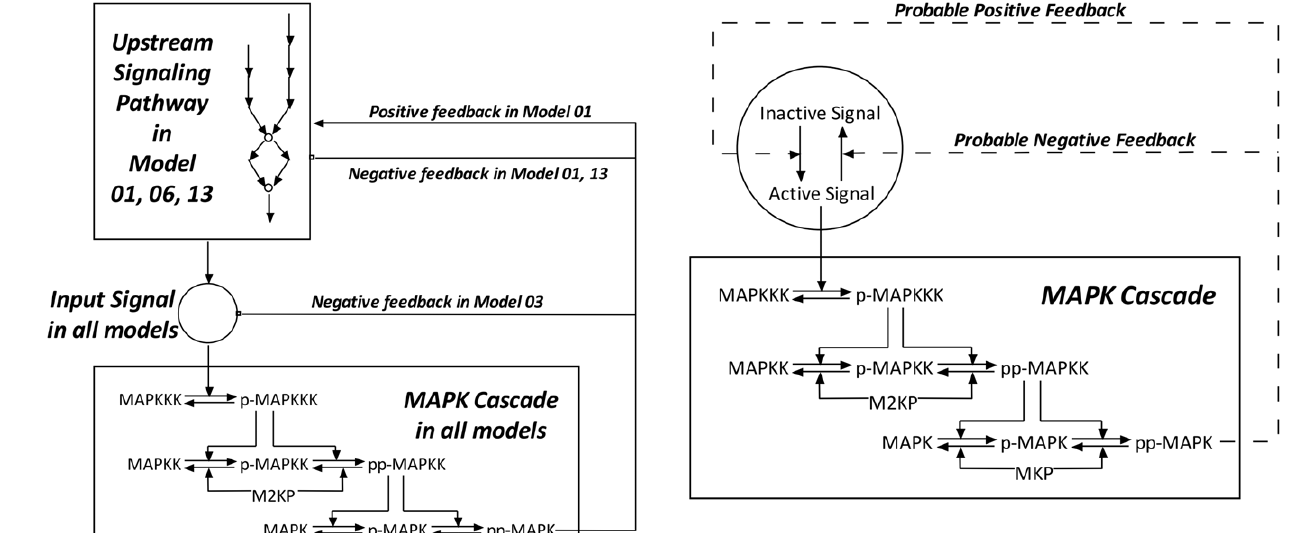
Figure 2. The topology of the generic model for MAPK activation. The presence or absence of the two probable feedbacks depends on the chosen kinetic parameters. In choosing the parameters, we applied the constraints that a particular parameter set can lead to either no feedback or the presence of only one of the feedbacks, but not the simultaneous presence of both feedbacks. In the Figure, the prefix p- means phosphorylated and pp- means dual-phosphorylated.